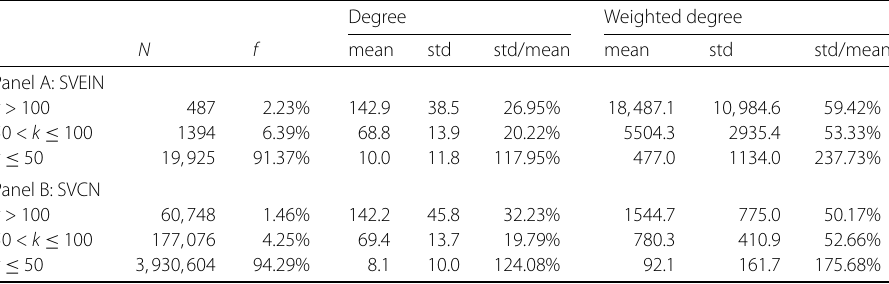
Figure 1 Illustration of the theoretical Dunbar Circle in ego networks. The square in the center represent the ego and the circles around are the alters, who have direct connection with the ego. The circle size is proportional to the emotional closeness between the alters and the ego. According to the emotional closeness, the alters form a hierarchical structure with different layers in which their closeness to the ego decrease from inner layer to the outer layer. The theoretical Dunbar Circle corresponds to a four-layer hierarchical structure with the cumulative number of 5, 15, 50, and 150 from inside to outside